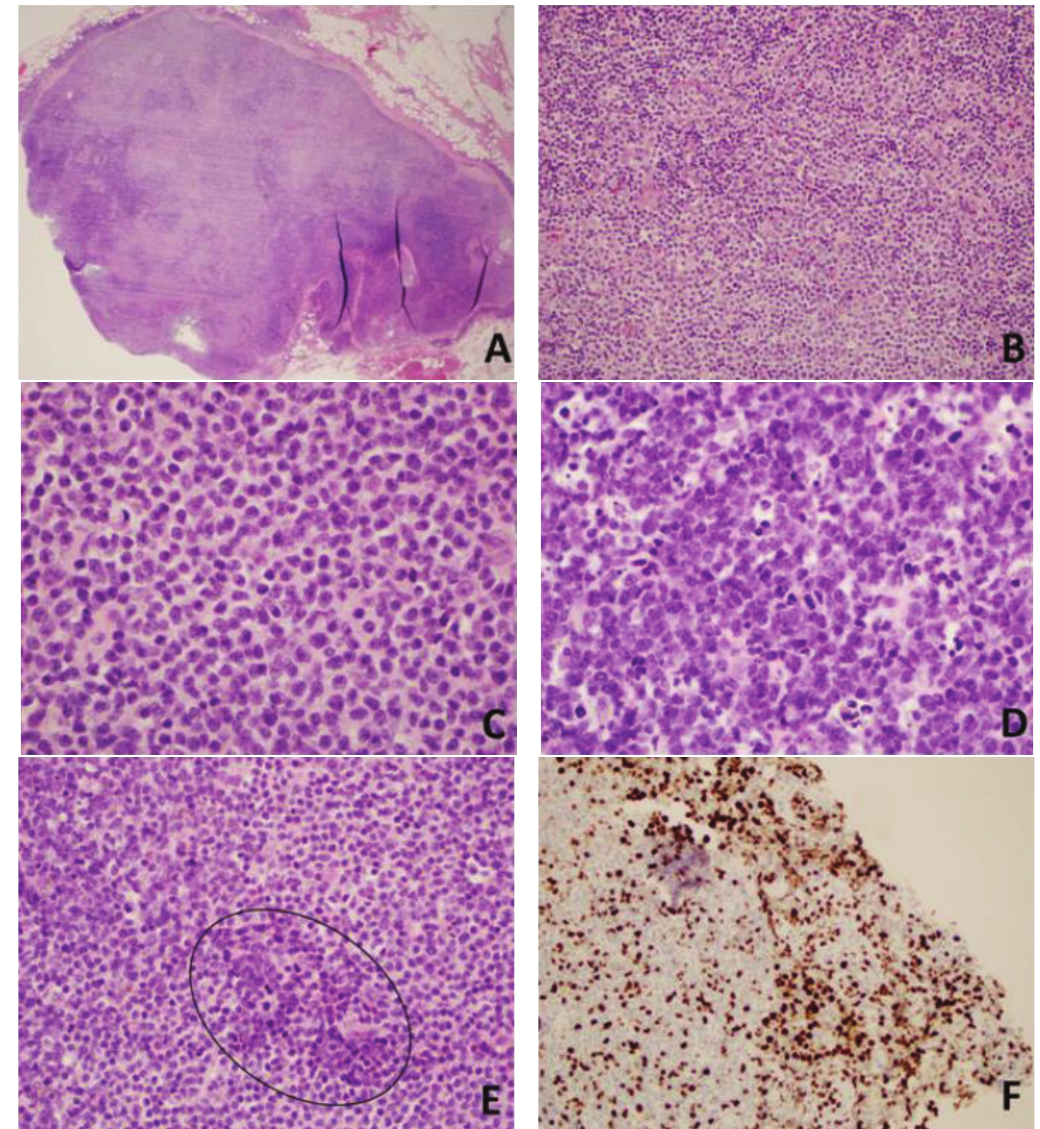
Figure 1: Histological features of lymph node. (A and B) Right posterior cervical lymph node, (A) H&E, 2x. The node is nearly completely effaced with minimal residual follicles. (B) H&E, 20x. Sheets of monocytoid cells in marginal zone. (C–F) Right cervical neck mass. (C) H&E, 60x. Sheets of monocytoid cells similar to those seen in the cervical lymph node. (D) H&E, 60x. Area of larger cells with focal necrosis. (E) H&E, 40x. Monocytoid cells and groups of larger cells (circle) with hyperchromasia. (F) MIB1 immunostain, 20x. Transformation areas with large cells show MIB-1 labeling index as high as